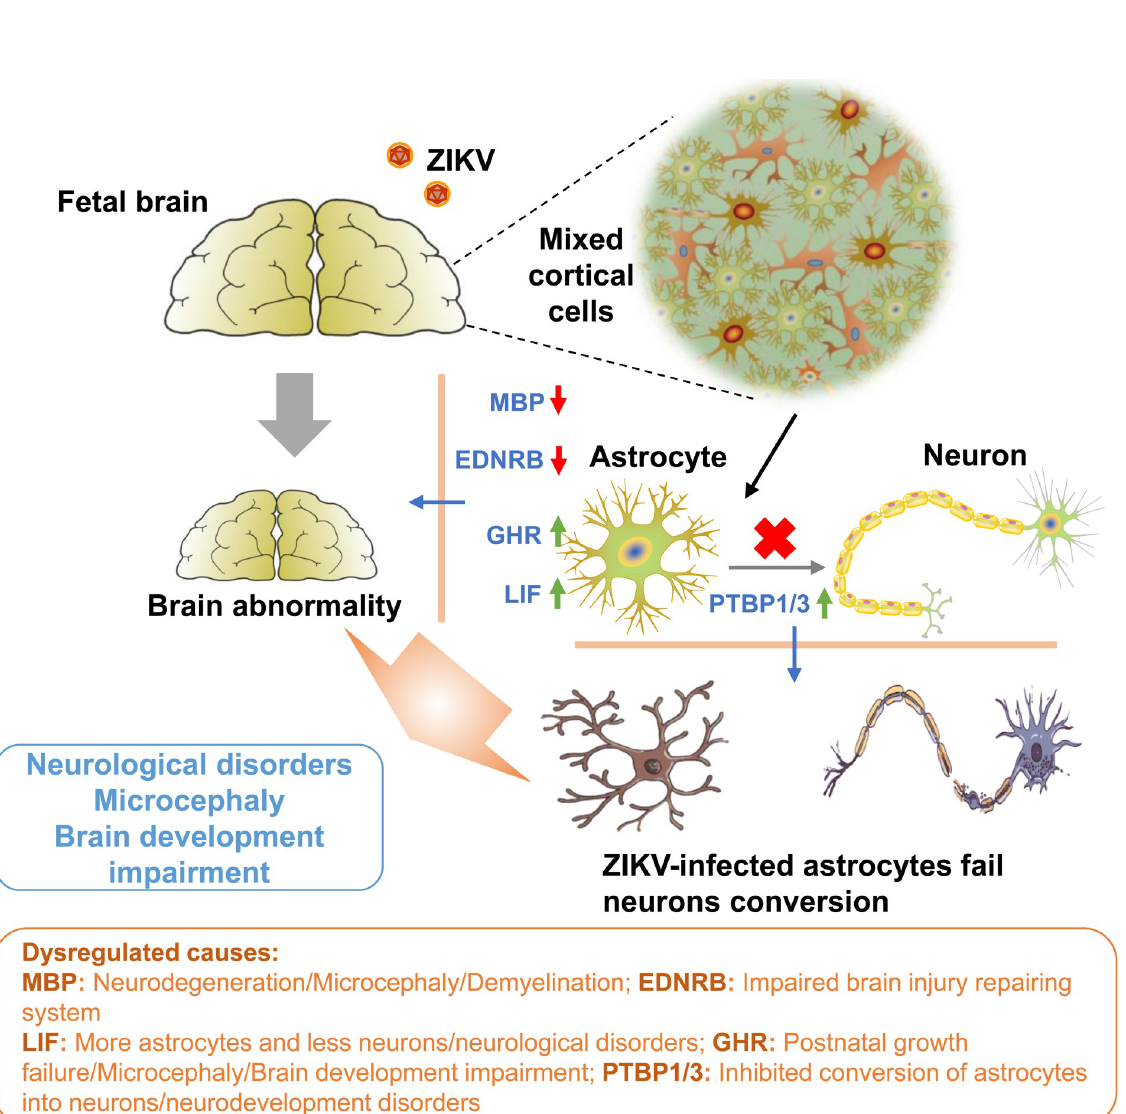
Fig 7. A mechanism underlying the brain-related neurological disorders upon ZIKV infection. The neurotropic ZIKV favorably infects and replicates in astrocytes of the fetal brain cerebral cortex. ZIKV can alter the astrocytic genes including PTBP1, LIF, PTBP3, GHR, EDNRB, and MBP, which are involved in various functions leading to neurological conditions such as microcephaly and brain development impairment. The numerical data used in all figures are included in S1 Data.